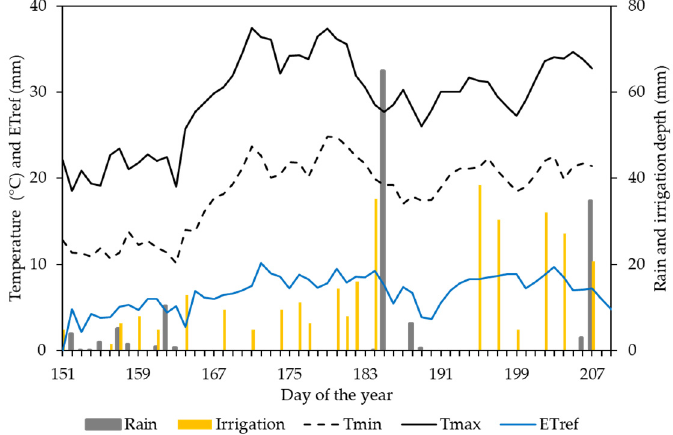
Figure 3. Daily values of minimum and maximum temperature (Tmin and Tmax), reference evapotranspiration (ETref), rain, and irrigation.